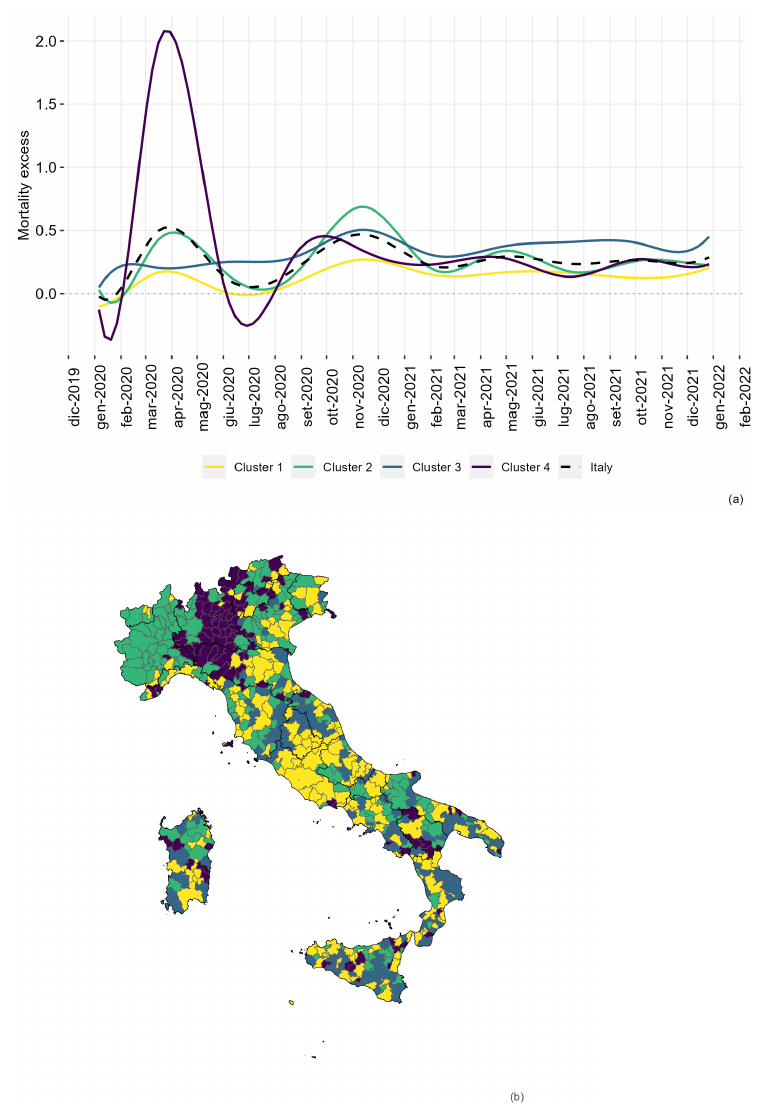
Figure 2. Average EM by cluster ( a ) and cluster distribution map ( b ) for the DFM [ α 12 bspline basis function, and four cluster. Cluster 1 curve is given in yellow, Cluster 2 in green, Cluster 3 in blue, Cluster 4 in